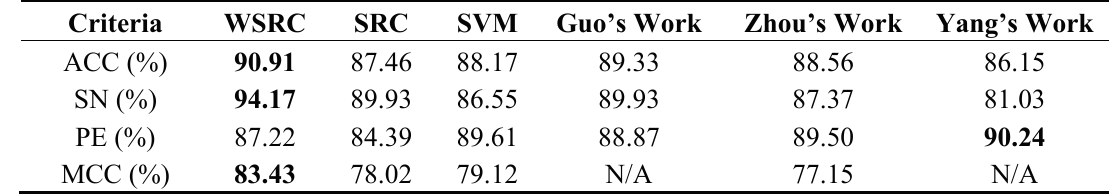
Table 7. Comparisons of WSRC with other classifiers. (The numbers in bold is the best result.). Criteria WSRC SRC SVM Guo’s Work Zhou’s